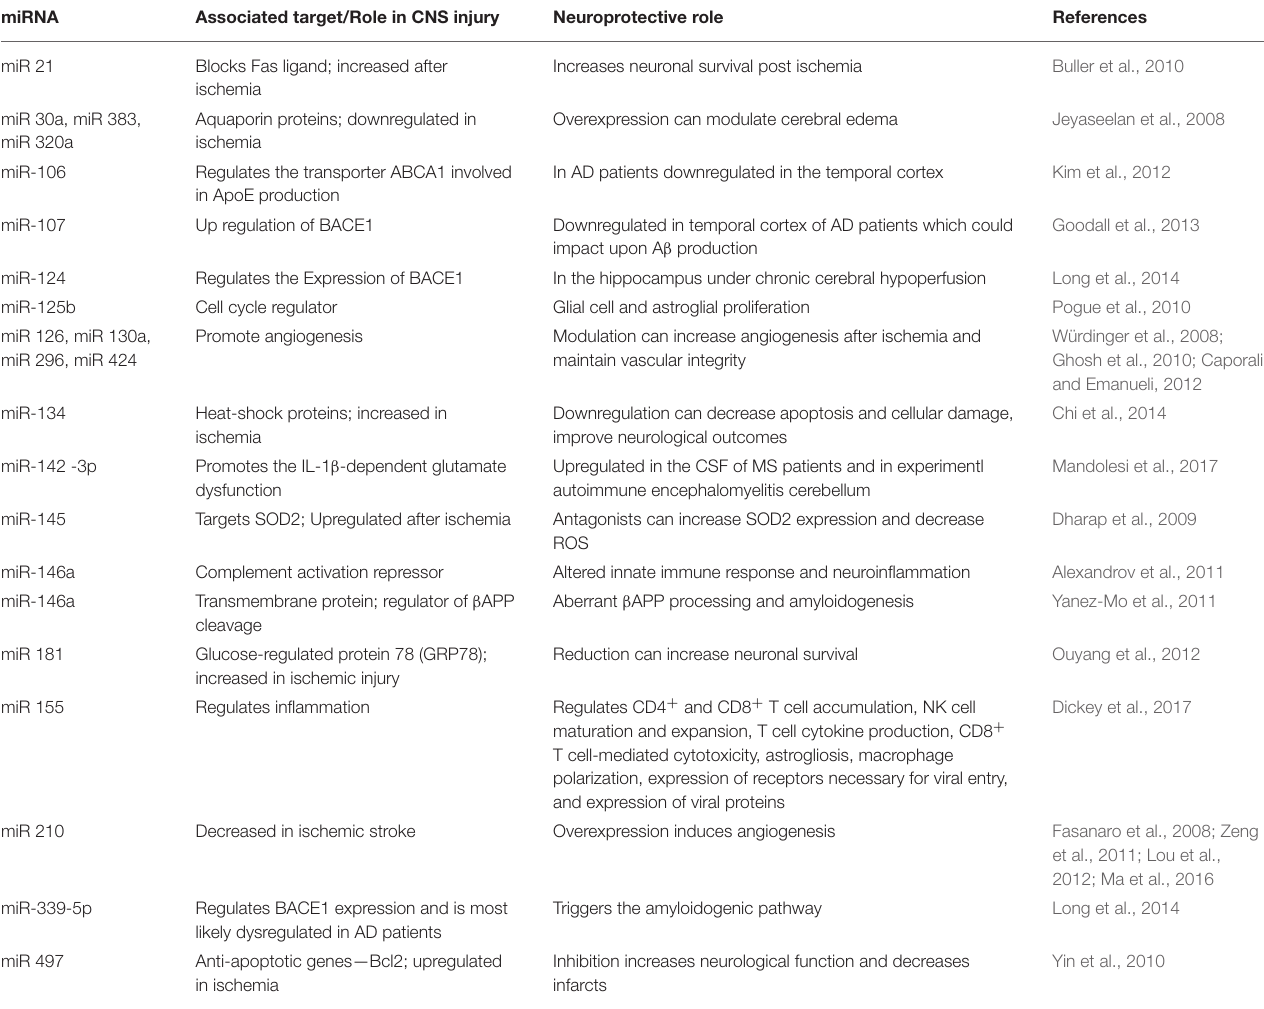
TABLE 1 | Different miRNA known to regulate hypoxia/ischemia associated genes and how these can play a neuroprotective role in CNS